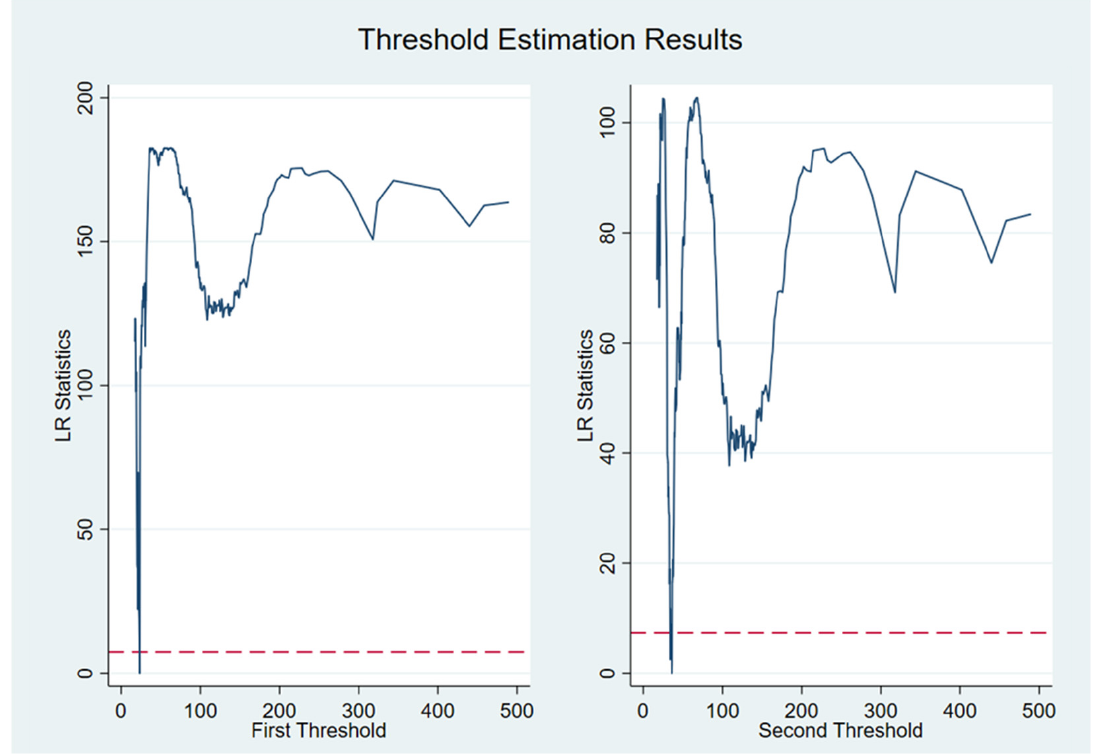
Figure 6. Double-threshold estimation results.